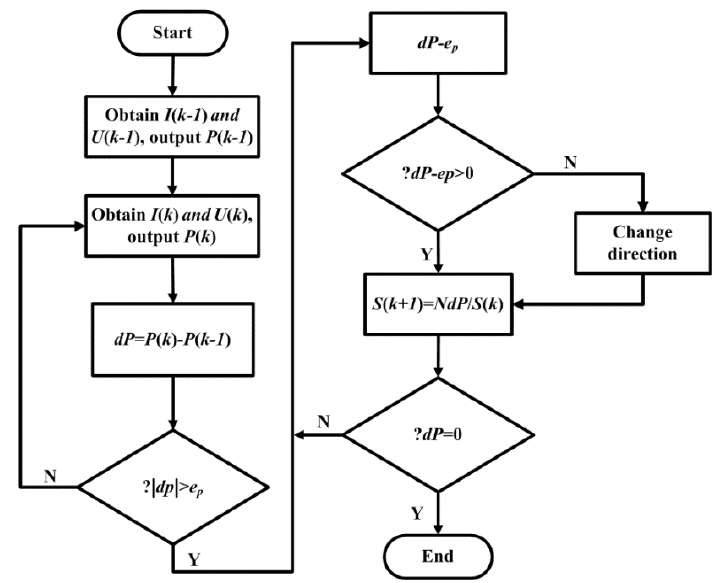
Figure 10. The flowchart of the perturbation and observation method with adaptive variable step.